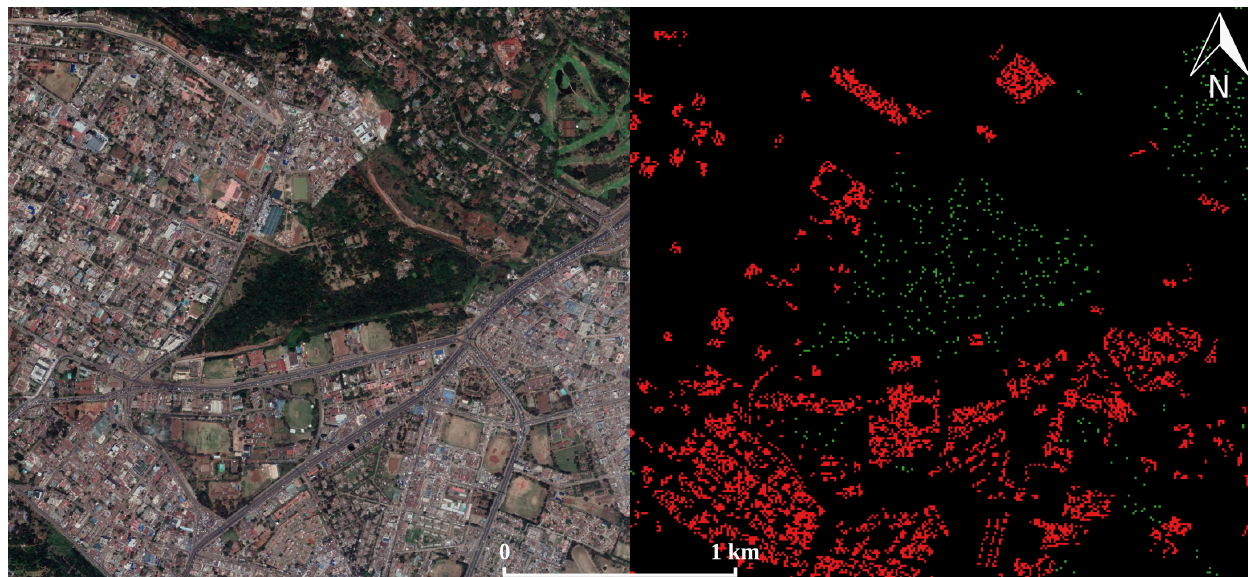
Figure 4. Training samples collected from OSM in Nairobi, Kenya. ( a ) Aerial view of the area of interest, courtesy of Goole Earth; ( b ) built-up (red) and non-built-up (green) training samples over the same area of